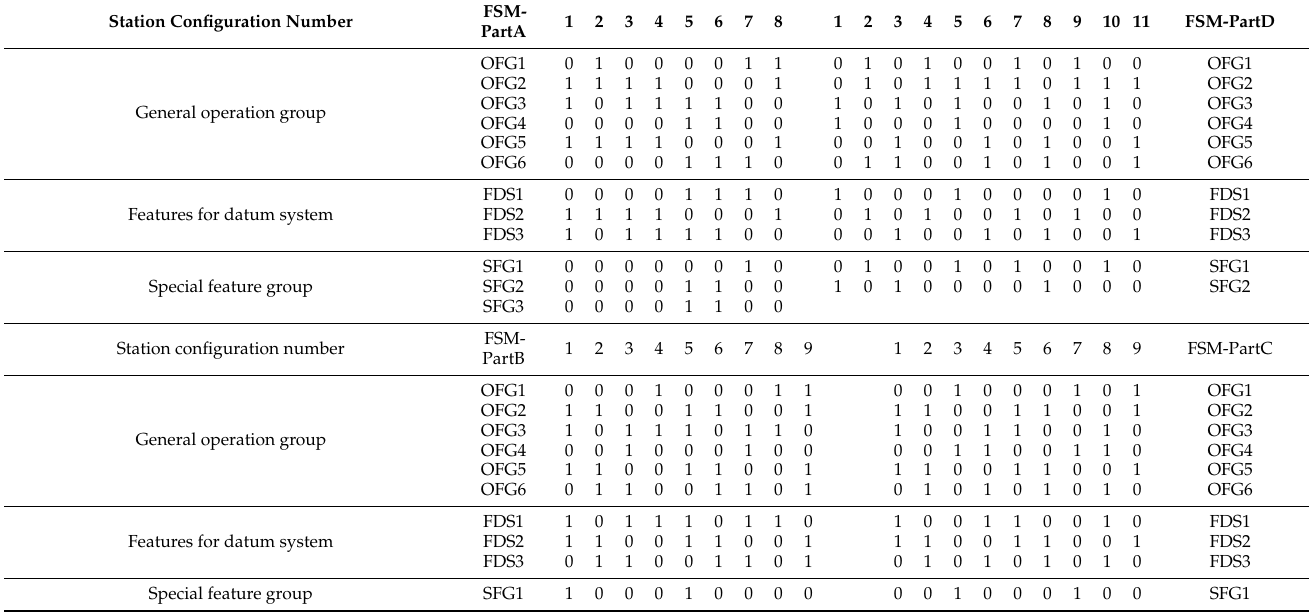
Table A5. Feature Group–Station Configuration matrix of the four